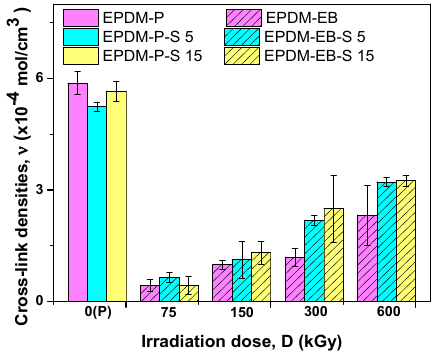
Figure 7. E ff ect of the cross-linking method (P / EB) and sawdust amount on the gel fraction. Figure 7. Effect of the cross-linking method (P/EB) and sawdust amount on the gel fraction.